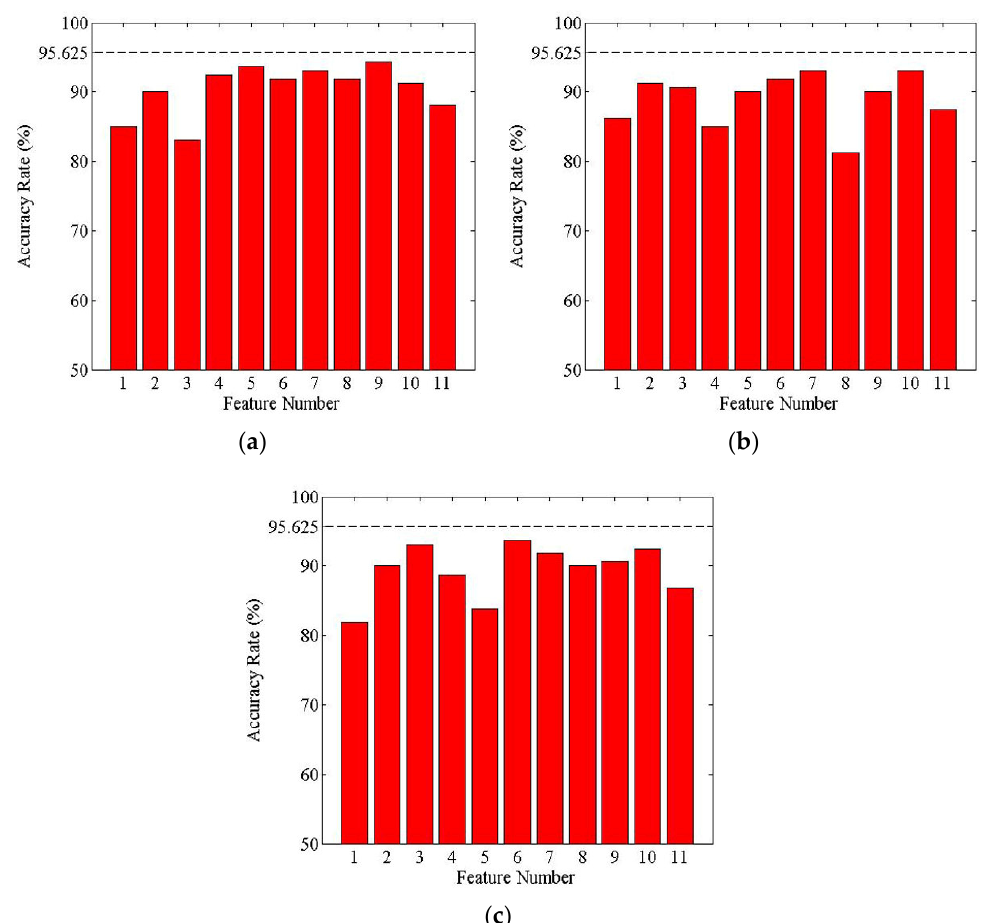
Figure 9. Ablation analysis of features in RGB space: ( a ) features of R component; ( b ) features of G component; ( c ) features of B component.1—Mean, 2—Median, 3—Maximum, 4—Minimum, 5—Common, 6—Range, 7—Variance, 8—Skewness, 9—Kurtosis, 10—Energy, 11—Entropy.